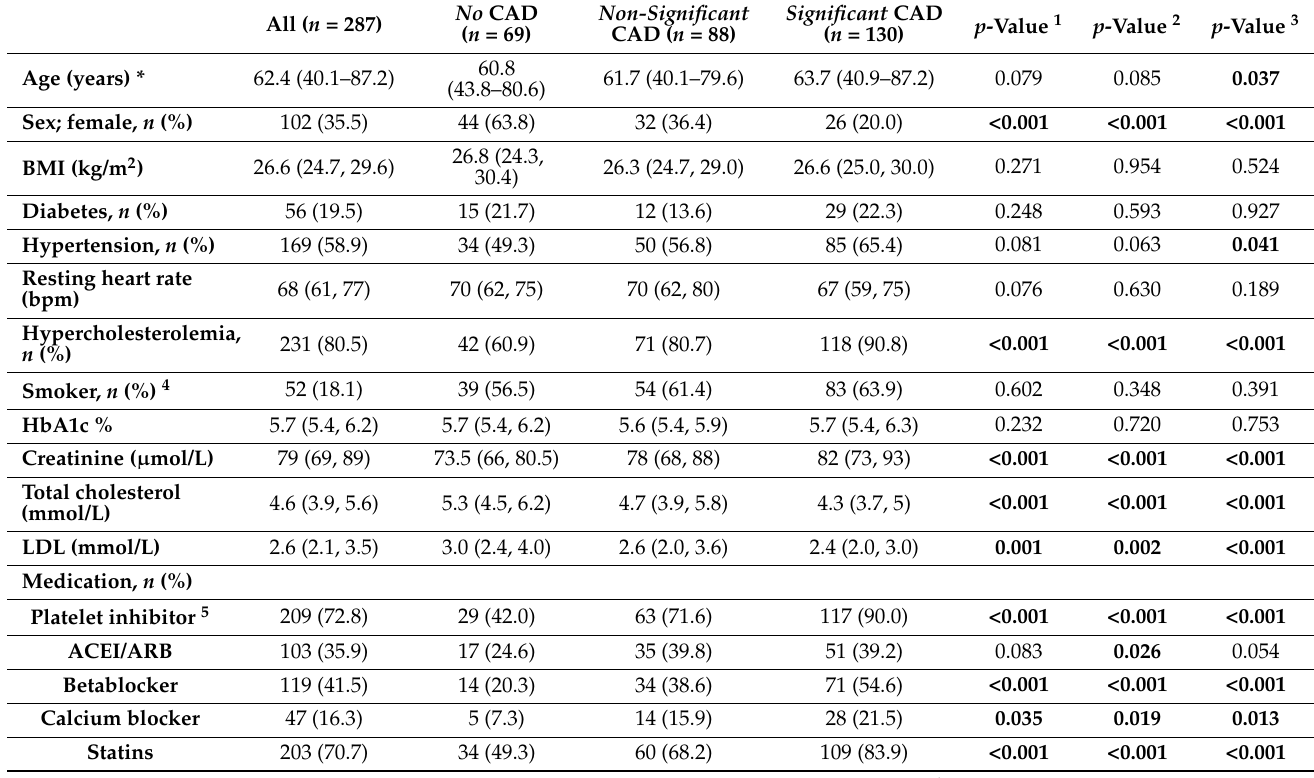
Table 1. Baseline characteristics of the total population and according to presence of